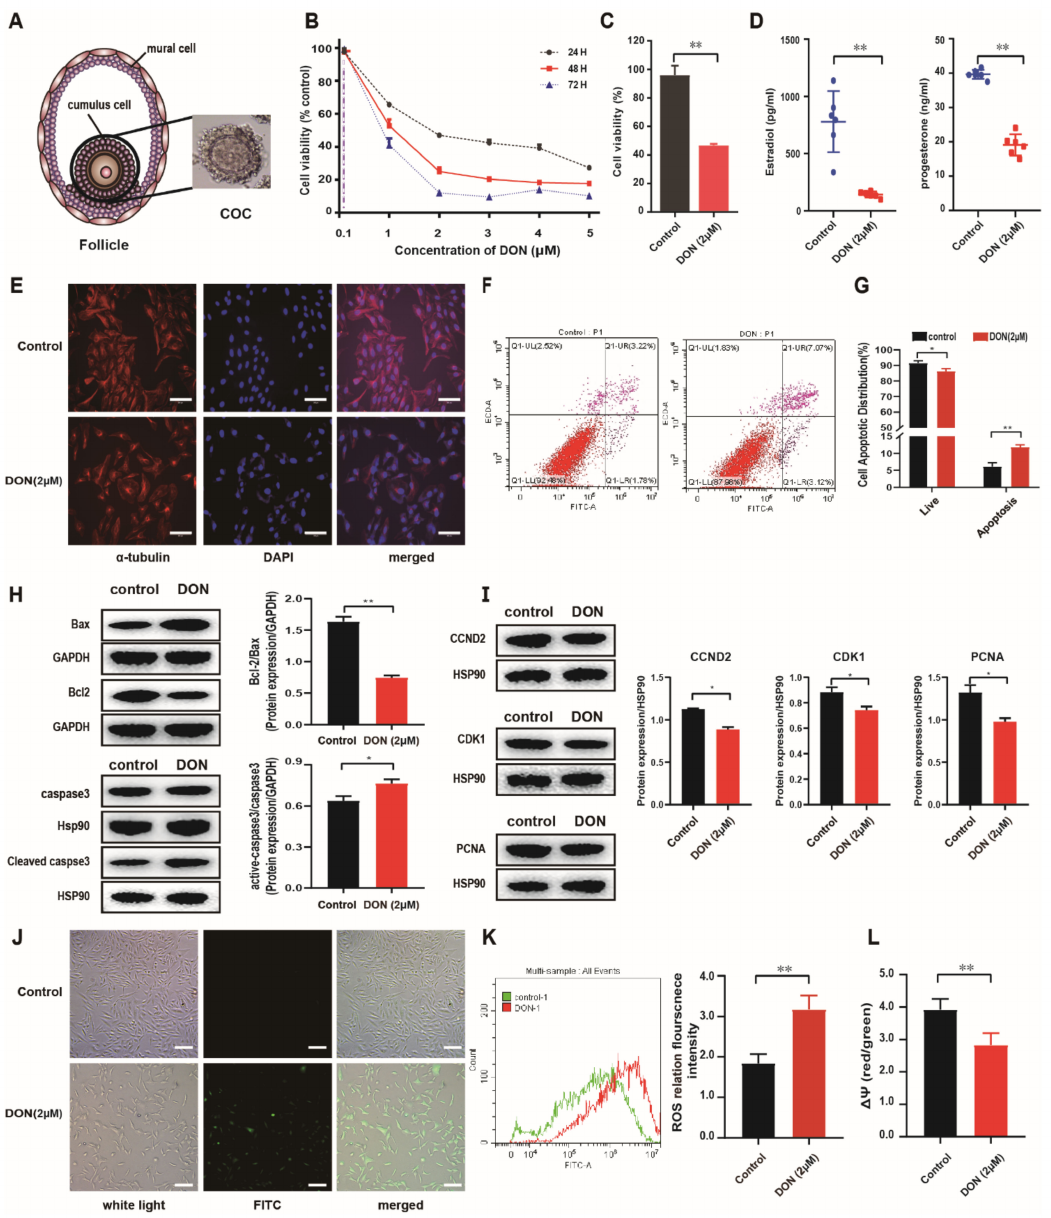
Figure 1. The toxicity effects of DON on murine ovarian granulosa cells. ( A ) The mode pattern of mammalian follicle